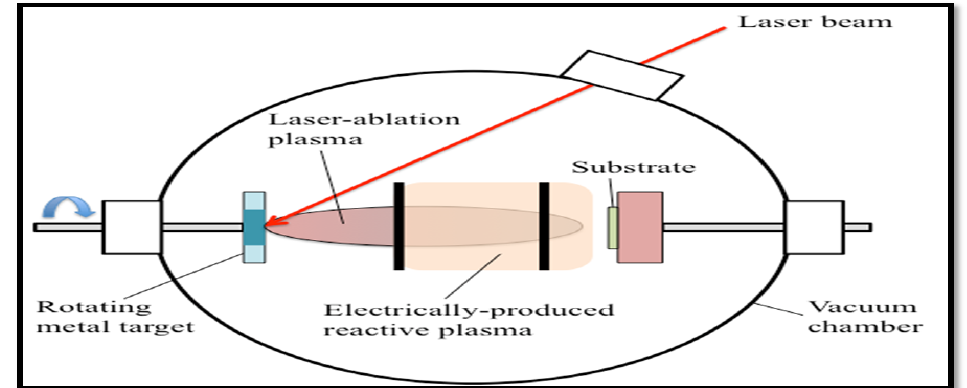
Fig. 1: Schematic diagram of a typical laser deposition